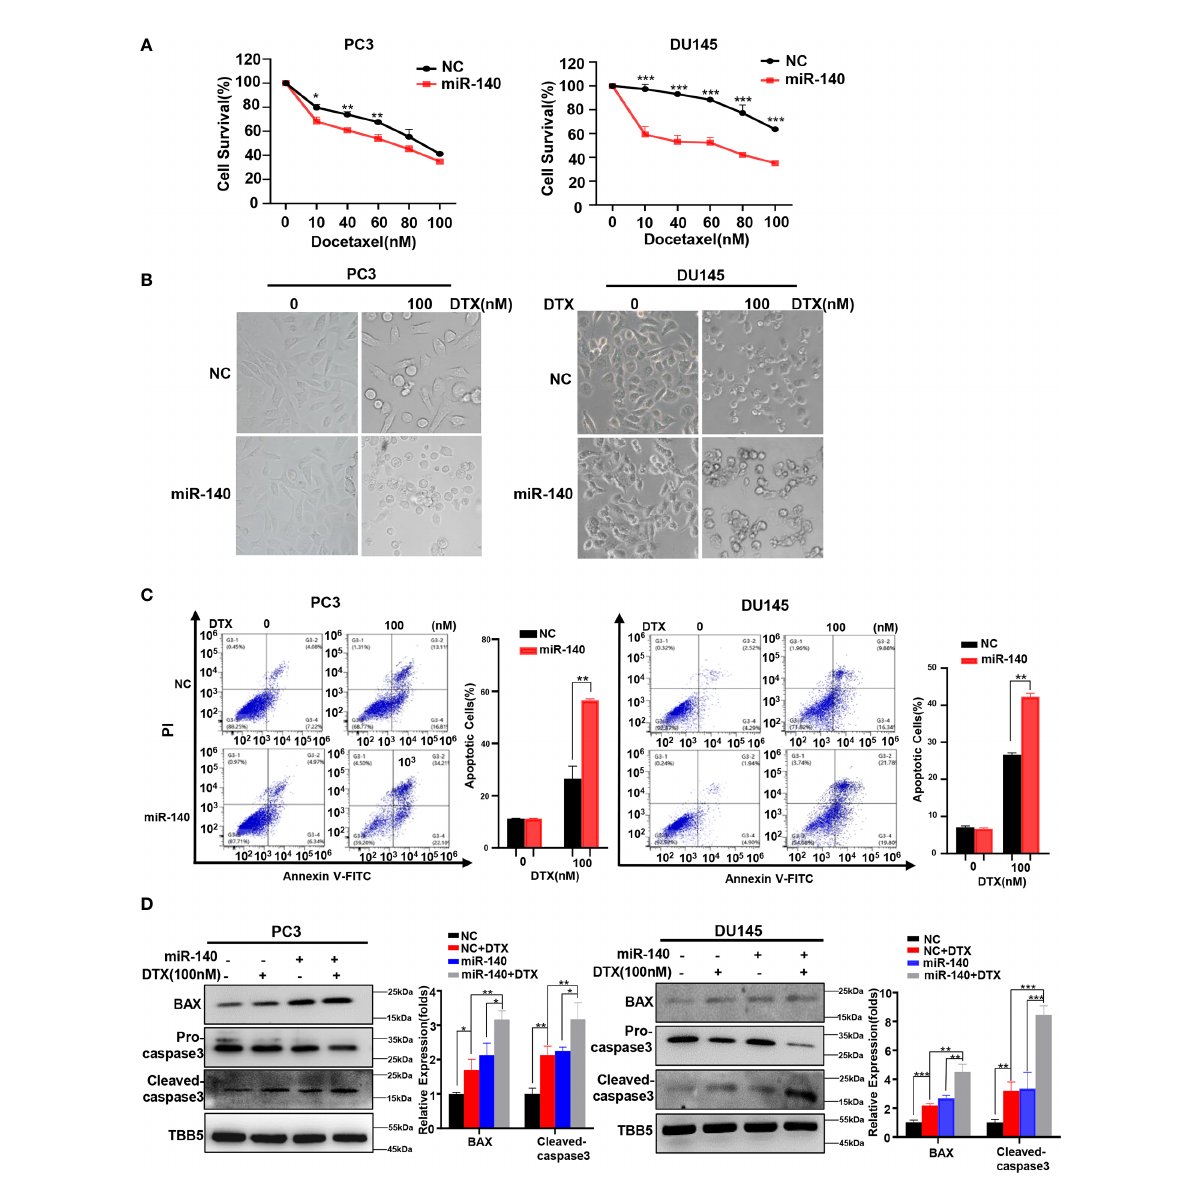
FIGURE 7 Overexpression of miR-140 enhances the sensitization of PC cells to docetaxel. (A) CCK8 assays using miR-140-overexpressing stable cell lines treated with docetaxel in PC3 and DU145. Data are expressed as the mean ± standard deviation (SD), n=3 per group. (B) Morphological analysis of control and miR-140-overexpressing cells treated with different doses of docetaxel. (C) Cell apoptosis was analyzed by fl ow cytometry. (D) Western blot (WB) analysis of BAX and caspase-3 levels in control or miR-140-overexpressing PC3 and DU145 cells treated with various concentrations of docetaxel. All statistical data are presented as the mean ± SD. *p < 0.05; **p < 0.01; ***p < 0.001 (Student ’ s